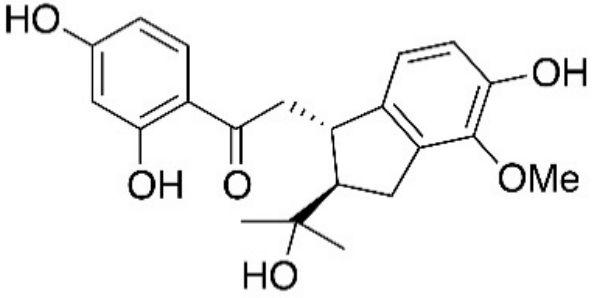
Figure 1. Chemical structure of Renifolin F.